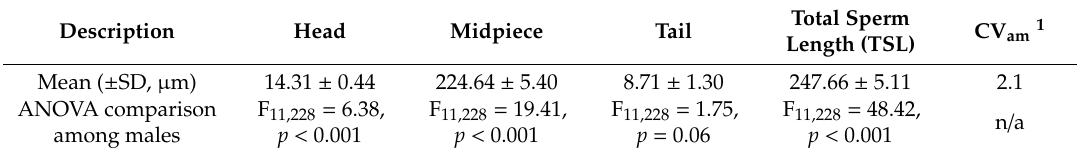
Table 1. Sperm component length comparisons for 12 black-throated blue warblers.